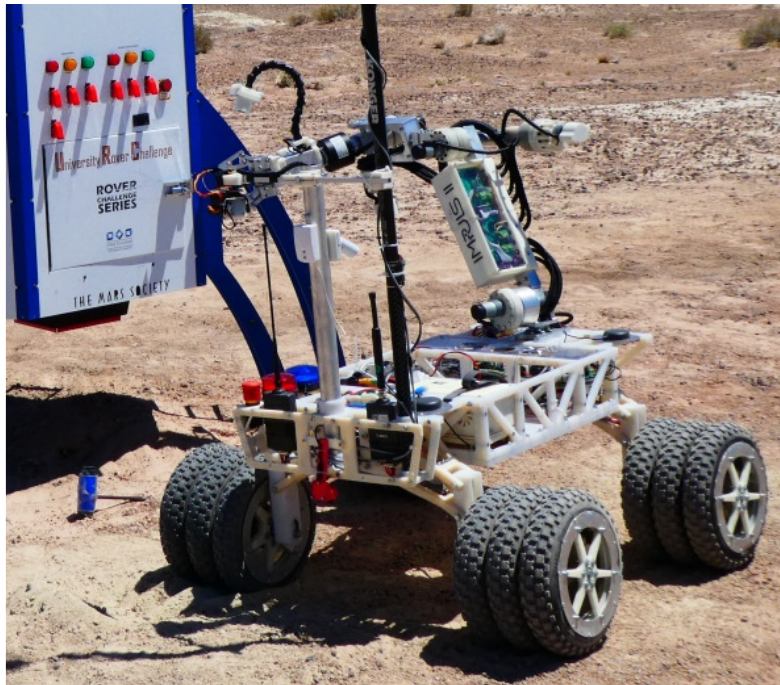
Figure 1. Mobile robot during analog simulation mission.